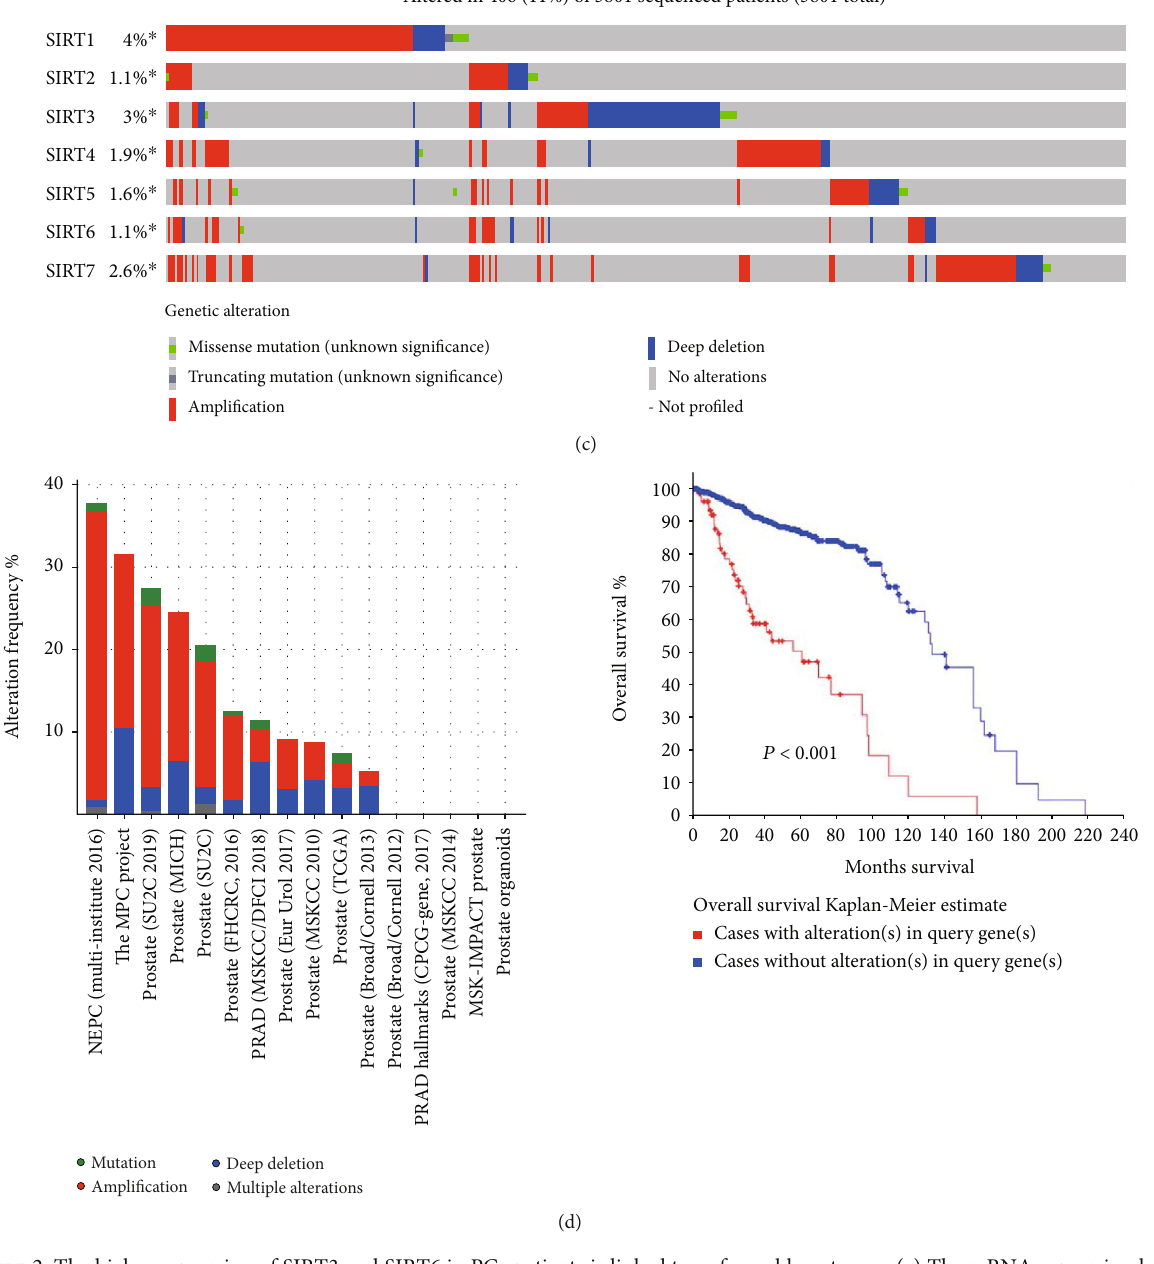
Figure 2: The higher expression of SIRT3 and SIRT6 in PCa patients is linked to unfavorable outcome. (a) The mRNA expression levels of SIRT3/5/6/7 were correlated with the nodal metastasis of PCa. N0: no reginal lymph node metastasis; N1: metastases in 1 to 3 axillary lymph nodes. ∗ P < 0 : 01 , ∗∗ P < 0 : 01 , and ∗∗∗ P < 0 : 001 . (b) The box plots of expression of SIRT genes in low (green) and high (red) risk groups of TCGA-PRAD patients. x -axis: gene expression value of each gene; P values are above the box plot. Kaplan-Meier survival plots showed that the high expression of the SIRTs was associated with poor survival in TCGA-PRAD patients. Red: high-risk group; green: low-risk group; top right corner inset: numbers of high- and low-risk samples, numbers of censored samples marked with and CI of each risk group; x -axis: time (days); y -axis; overall survival probability. (c) Gene alterations in SIRT genes queried from 3801 patients in 16 studies. (d) The frequency of alterations in SIRT genes in 16 individual prostate cancer studies. Genetic alterations in SIRTs were associated with shorter OS of PRAD